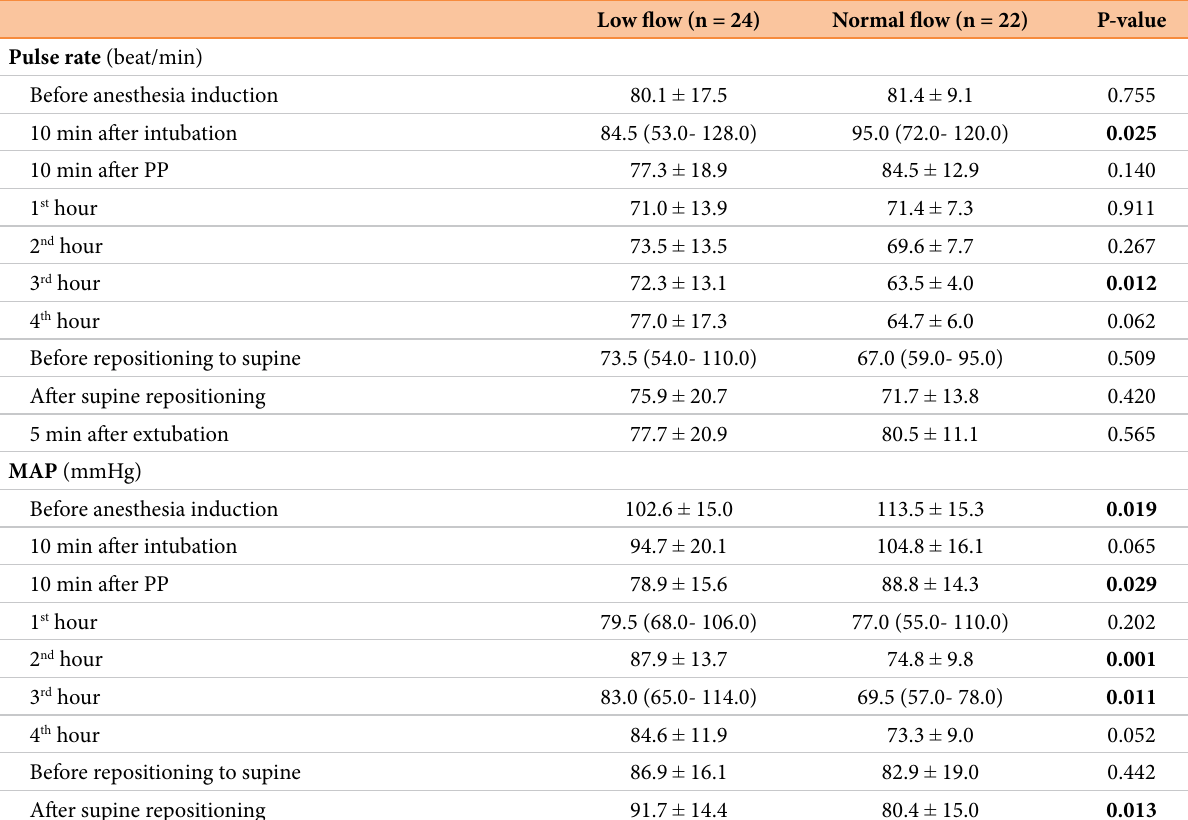
Table 2 – Comparison of pulse rate, mean arterial pressure, minimal alveolar concentration, and end-tidal carbon dioxide during measurement time